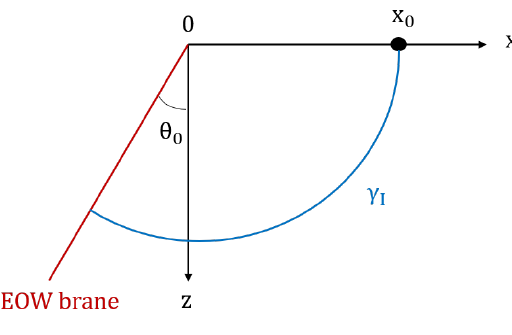
Figure 1 . The set up of AdS/BCFT where the brane tension is a